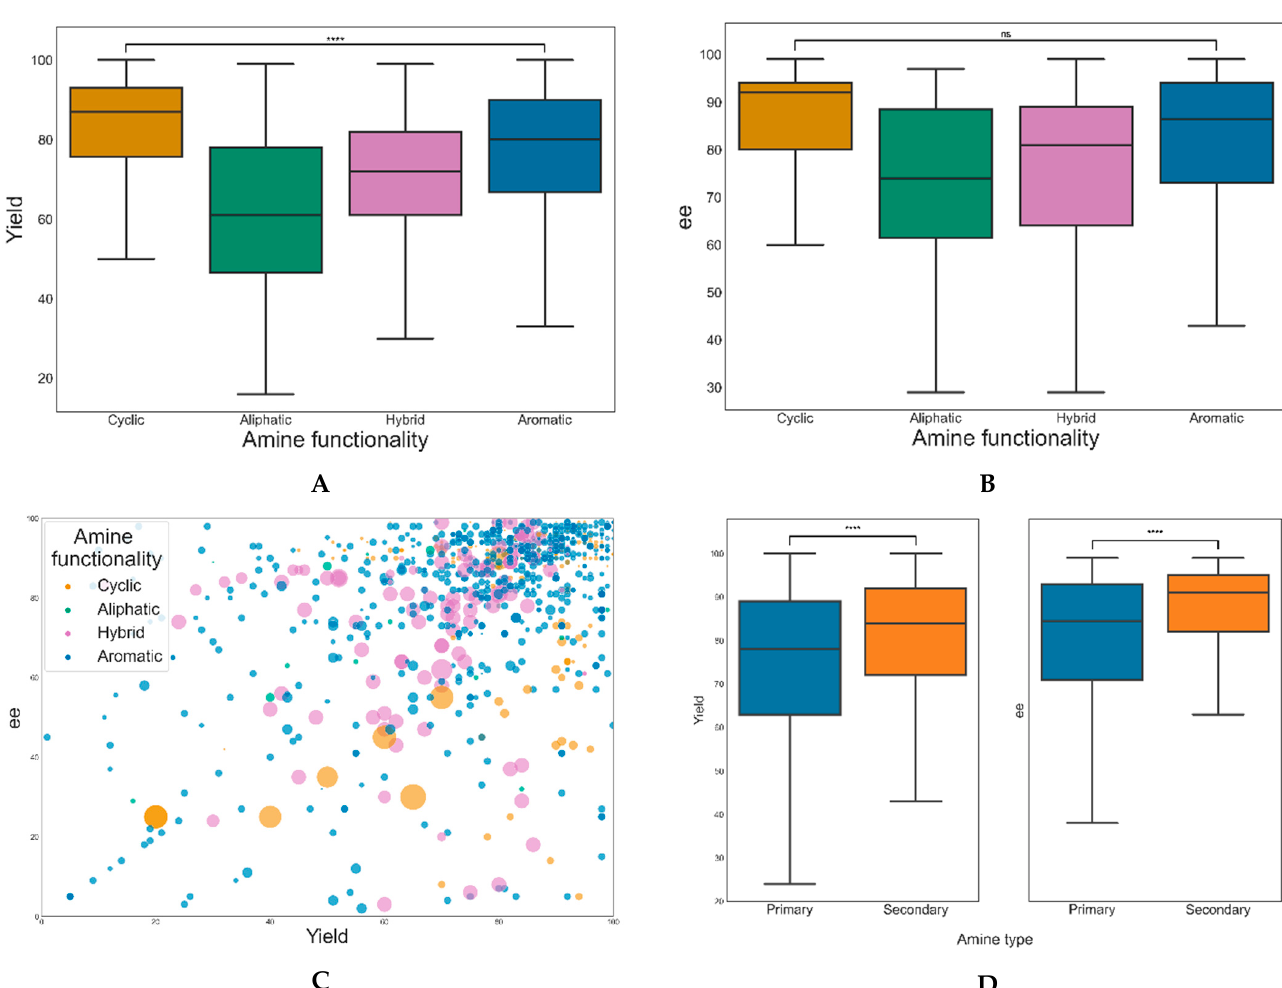
Figure 13. ( A ) Yield of amines with different functionalities; statistical analysis performed using Student’s t -test ( p = 0.0002). ( B ) ee of amines with different functionalities; statistical analysis performed using Student’s t -test ( p = 0.19). ( C ) Distribution of amines with enantioselectivites greater than 0, ( D ) comparison of primary vs. secondary amines on yield and ee . Statistical analysis for C and D wasperformed using Student’s t -test ( p = 1.42 × 10 − 5 , 3.54 × 10 − 5 ) ( right ). Symbol Meaning: ns p > 0.05, **** p ≤ 0.0001 (For the last two choices only).